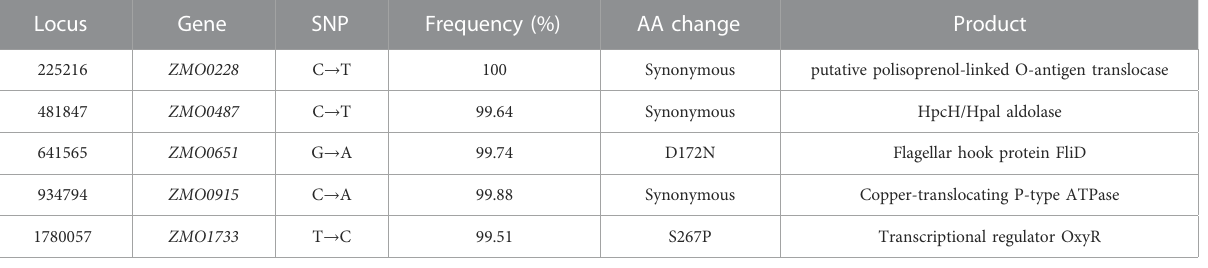
TABLE 1 Single-nucleotide polymorphisms (SNPs) in ZMNP compared to ZM4.